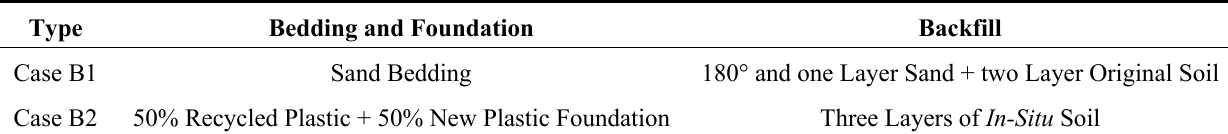
Table 8. Cases for the second field test.